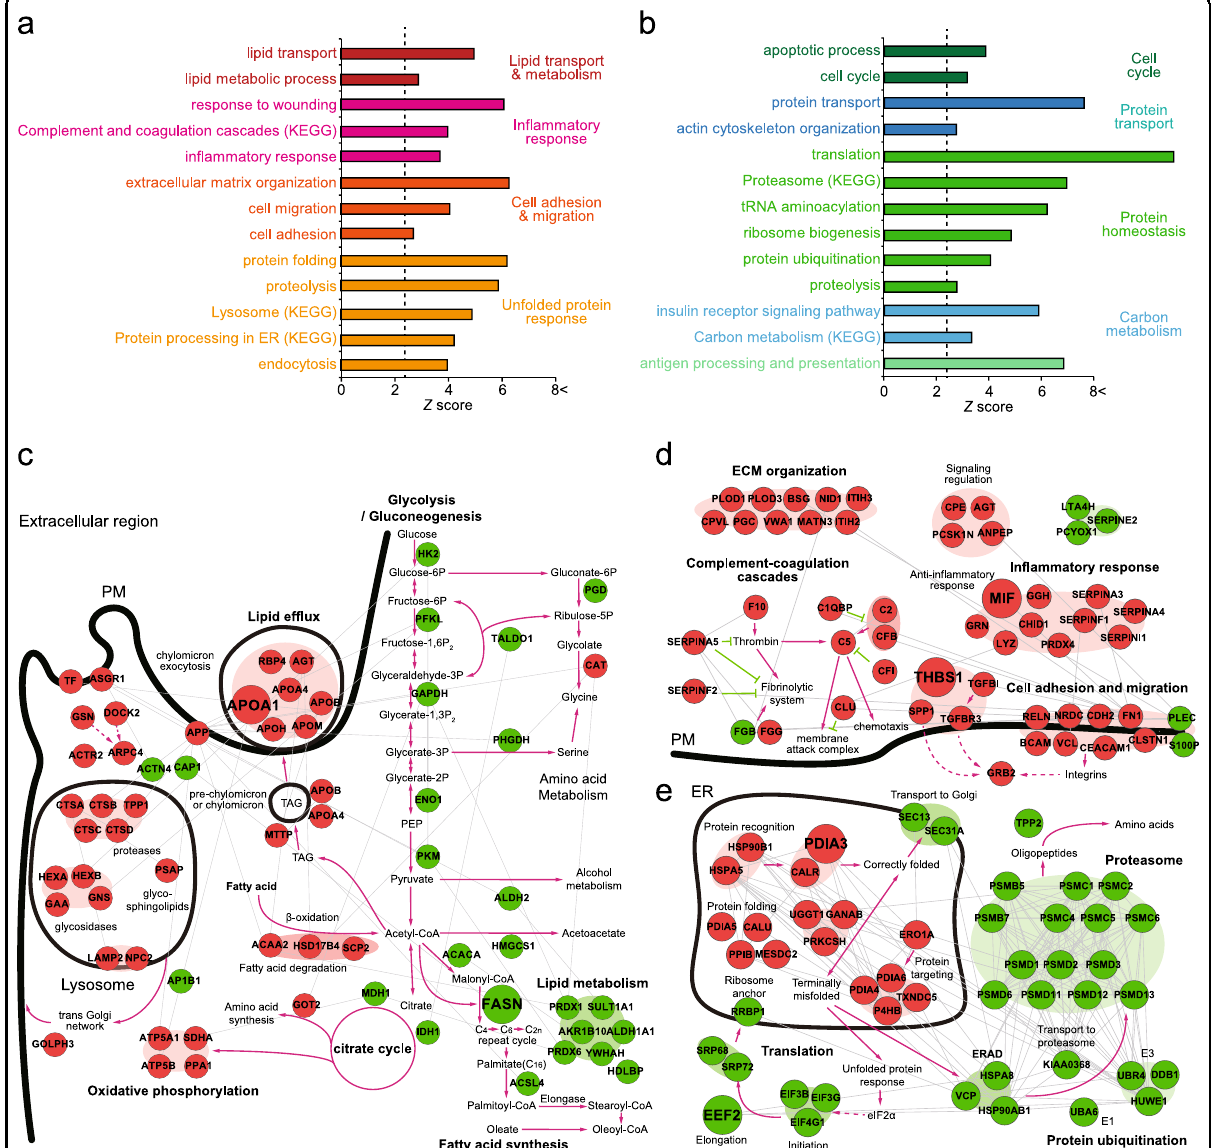
Fig. 3 Cellular processes represented by DSPs between oleate-treated and untreated samples and network models delineating key cellular processes. a , b Cellular processes (GOBPs) enriched by upregulated ( a ) and downregulated ( b ) secreted proteins between oleate-treated and untreated samples. Each bar represents the Z -score of the P value that is the signi fi cance of the corresponding GOBP being enriched by the DSPs. The dashed line denotes the cutoff of P = 0.01. Bar colors represent the groups of GOBPs associated with the indicated cellular events. c – e Network models describing interactions among DSPs involved in FA removal and production ( c ), in fl ammatory responses and cell adhesion/ migration ( d ), and ER stress and protein degradation ( e ). Node colors represent up- (red) and down-regulation (green) of secreted proteins after oleate treatment. Large nodes indicate the six secreted proteins selected as a secretome pro fi le in this study. Nodes were arranged according to GOCCs and the localization information obtained from the Kyoto Encyclopedia of Genes and Genomes (KEGG) pathway database. Gray lines represent protein-protein interactions, and the arrows and inhibition symbols obtained from the KEGG pathway database denote activation and suppression, respectively. Thick black lines denote membranes, such as plasma membrane (PM), lysosomal ( c ) and ER ( e ) membranes, and vesicular membranes ( c